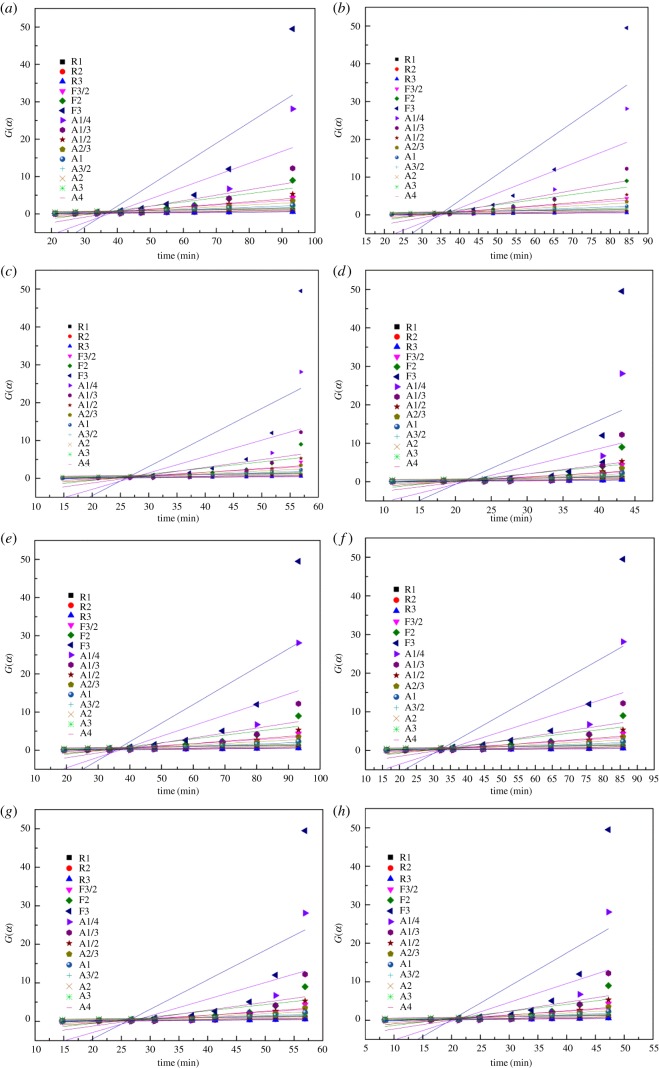
Trends of G(α) versus t under different temperatures with common mechanism functions for the YBaCo4O7+δ oxidation process at (a) 290°C, (b) 310°C, (c) 330°C and (d) 350°C; for the Y0.95Ti0.05BaCo4O7+δ oxidation process at (e) 290°C, (f) 310°C, (g) 330°C and (h) 350°C; and for the Y0.5Dy0.5BaCo4O7+δ oxidation process at (i) 290°C, (j) 310°C, (k) 330°C and (l) 350°C.